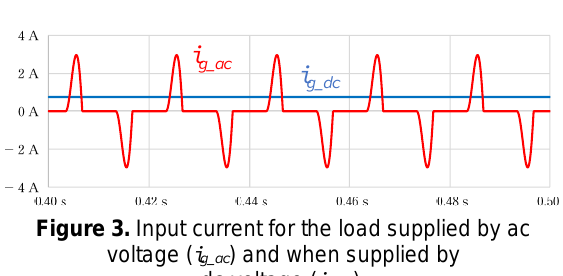
Figure 3. Input current for the load supplied by ac voltage ( i g_ac ) and when supplied by dc voltage ( i g_dc ).